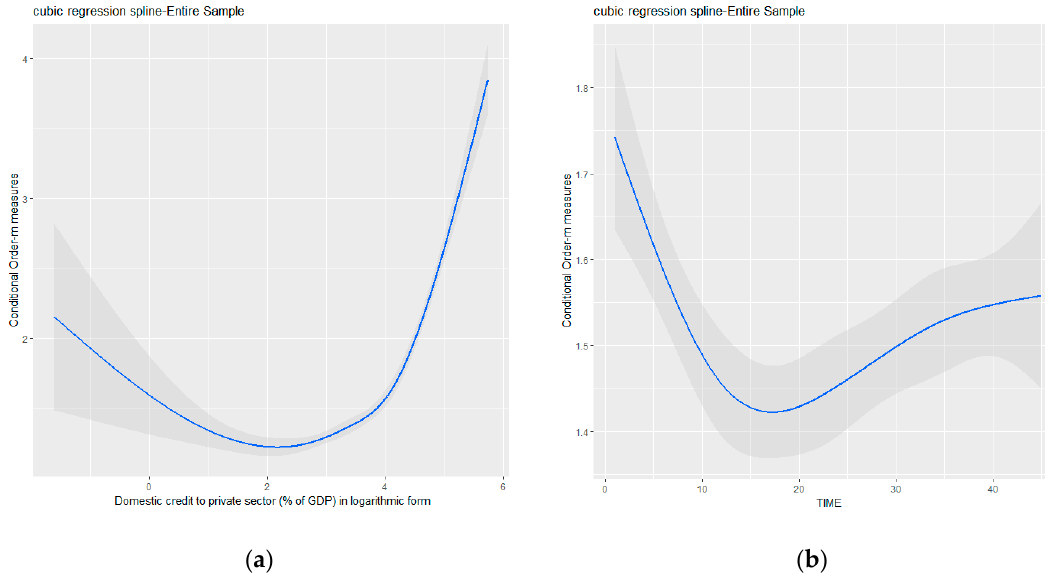
Figure 3. The effect of domestic credit and time on countries production efficiencies (entire sample): ( a ) The effect of domestic credit to private sector (entire sample); ( b ) the effect of time (entire sample).